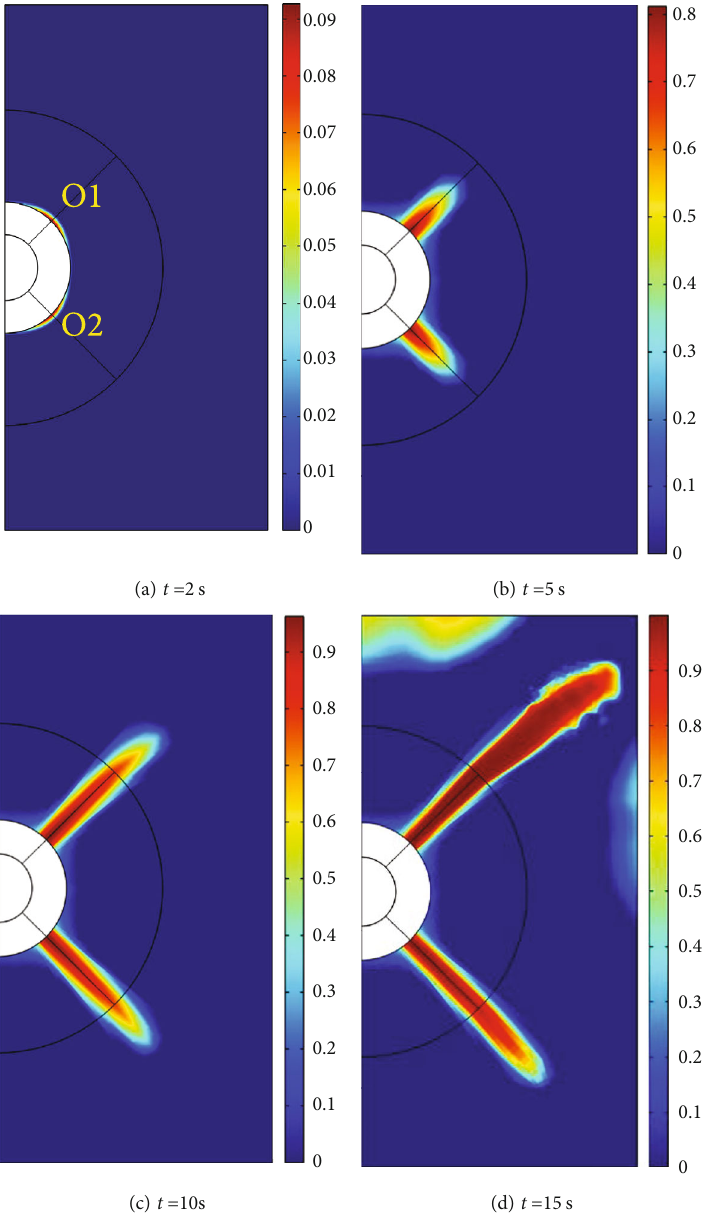
Figure 3: Damage evolution results of group